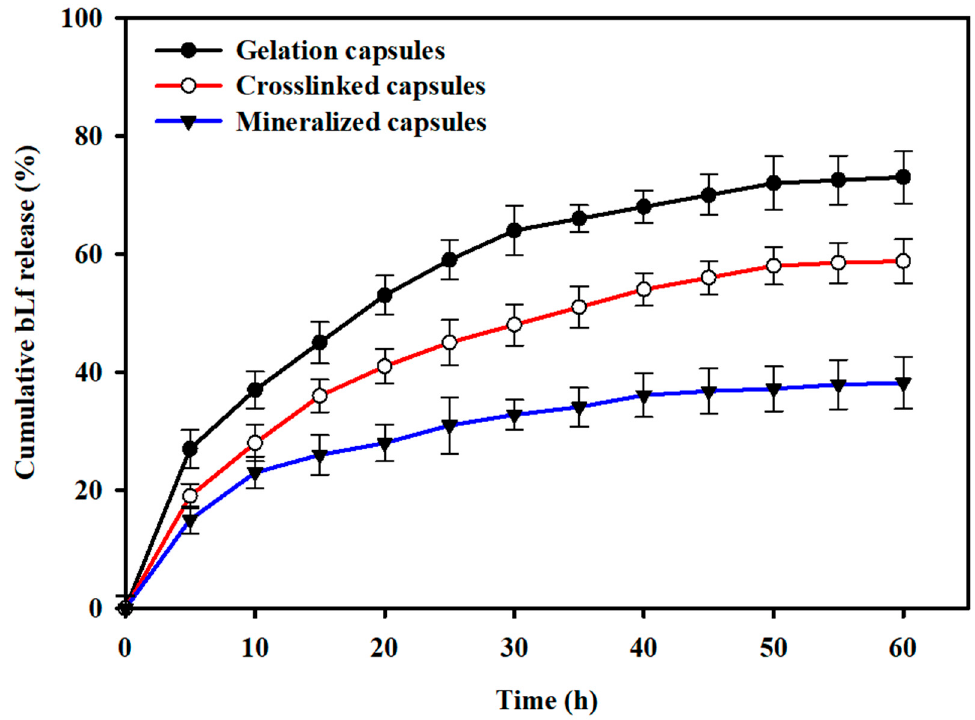
Figure 7. In vitro drug release profiles: The drug release from the gelation-encapsulated, crosslinking-encapsulated, and mineralization-encapsulated L. rhamnosus GG cells was studied in PBS at pH 7.4.